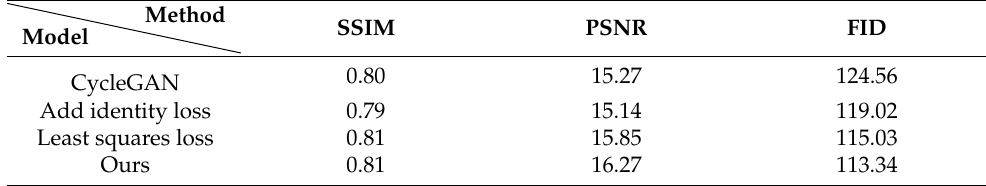
Figure 10. Ablation study: ( a ) Input face photos. ( b ) CycleGAN. ( c ) Add identity loss. ( d ) Use the least squares loss function. ( e ) Ours. ( f ) Ground truth. Table 3. Quantitative results of improved CycleGAN